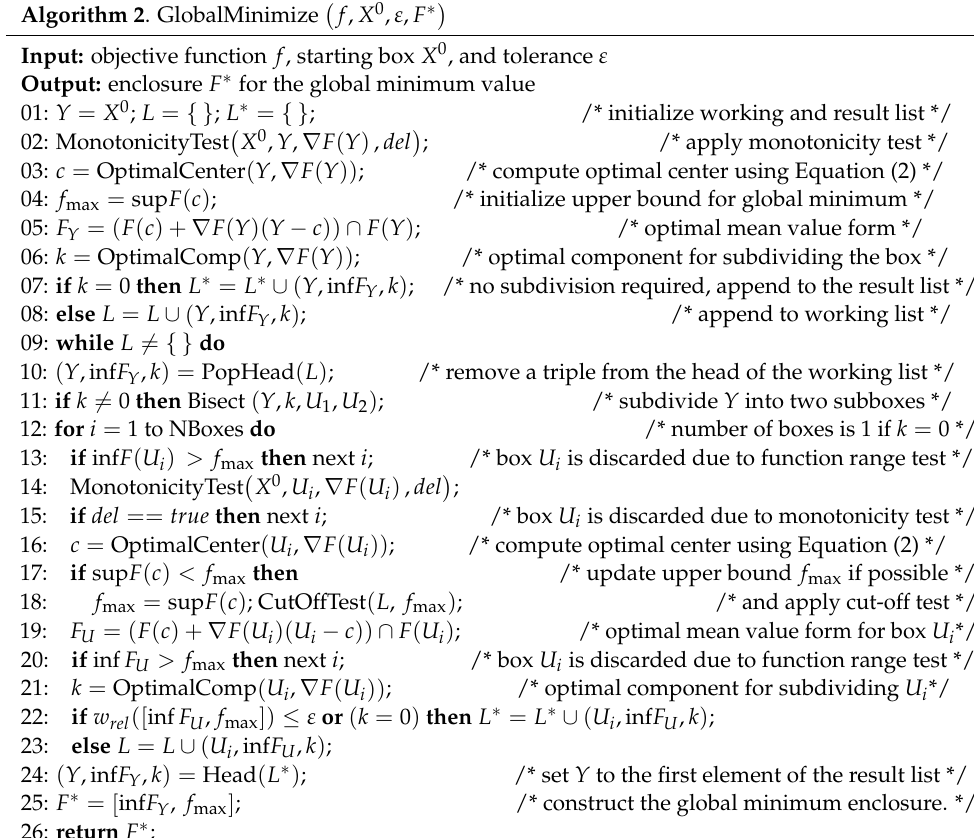
(cid:0) f , X 0 , ε , F ∗